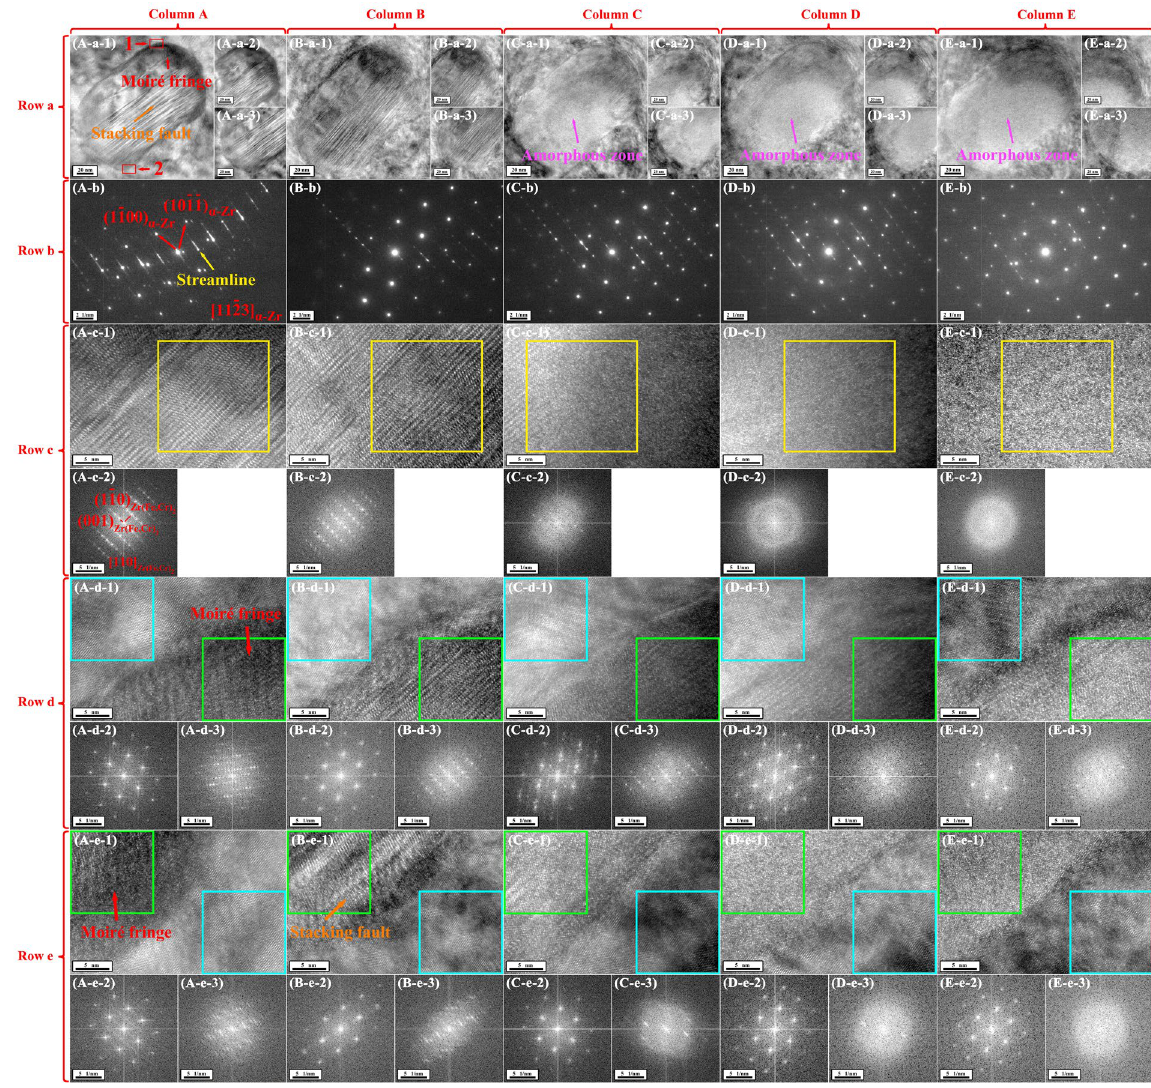
Figure 3. TEM observations of the precipitate of interest and its surrounding α -Zr matrix before and after irradiation at room temperature with focused and stationary electron beam at an incident energy of 30 keV in the FE-SEM viewed along the [11 ̄ 2 3] α -Zr direction. Column A–E of Fig. 3 shows TEM results before and after irradiation for 32, 64, 96, and 128 electron beam scans, respectively. Row a of Fig. 3 shows BF TEM images of the precipitate of interest and its surrounding α -Zr matrix. Row b of Fig. 3 shows composite SAED patterns of the precipitate of interest and its surrounding α -Zr matrix. Row c–e of Fig. 3 show HRTEM images and their corresponding FFT diffraction patterns corresponding to the center (not the same position), the up-left corner (Area 1 in Fig. 3(A-a-1)) and the down-right corner (Area 2 in Fig. 3(A-a-1)) of the precipitate of interest, respectively. In Row c of Fig. 3, the FFT diffraction pattern in every column corresponds to the area outlined by a yellow square in the corresponding HRTEM image. In Row d and e of Fig. 3, the left and right FFT diffraction patterns in every column of Fig. 3 correspond to the areas outlined by blue and green squares in the corresponding HRTEM image,